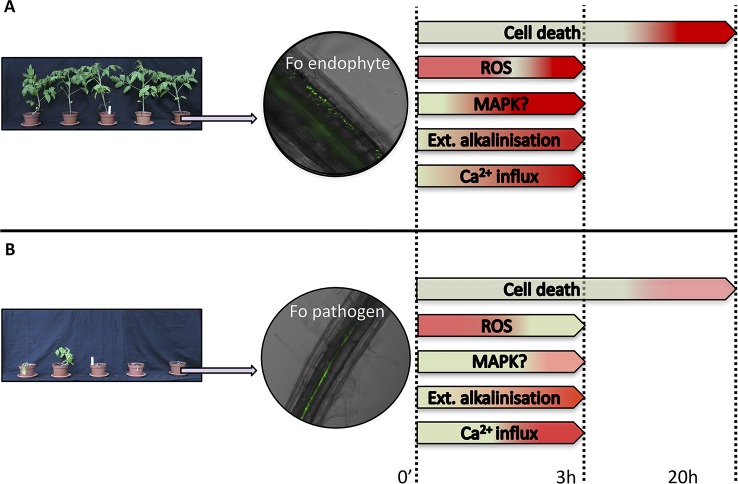
Schematic representation of plant responses upon Fusarium oxysporum (Fo) inoculation. Responses of plants following exposure to a Fo endophyte (A) or a pathogen (B). Pictures on the left show representative phenotypes of tomato plants upon inoculation with either an endophytic or a pathogenic Fo strain. Middle panels show root colonization by GFP-labeled Fo strains visualised by fluorescence microscopy. The right panel summarizes early signaling responses upon Fo exposure to plant cell cultures (Olivain et al., 2003; Humbert et al., 2015). The response amplitudes are color-coded from green (lowest) to red (highest).